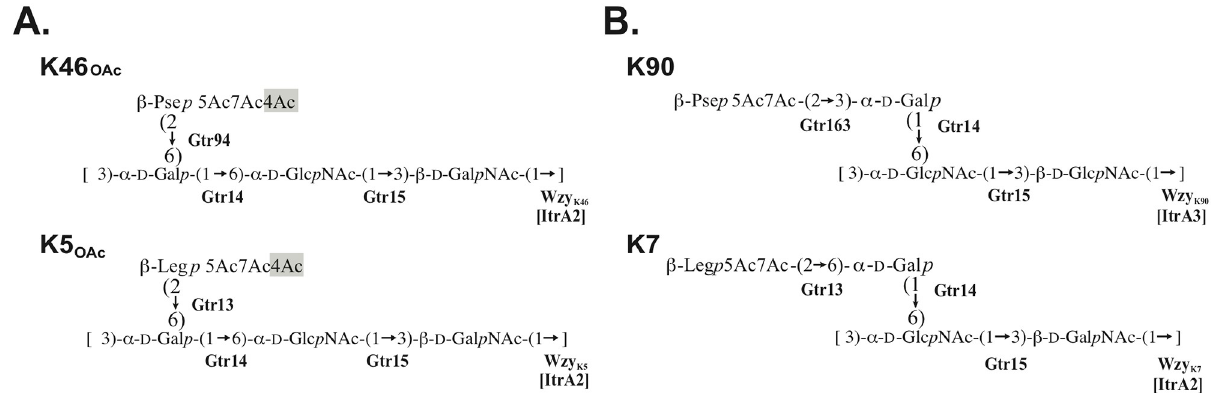
Fig 4. A. CPS structures NIPH329 (this work) and SDF [5] with 4-O-acetylation of the non-2-ulosonic acid residue. B. Related CPS structures of A